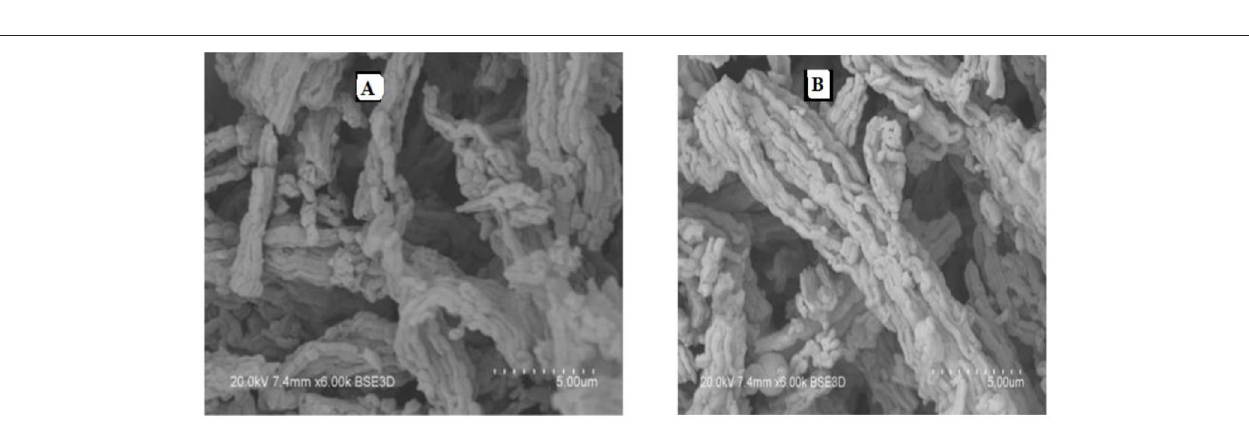
the 13IMPNi18LaN-B spent sample. For the 10IMPNi6LaN- A spent sample, the weight loss was 19.0 wt%, while for the 16IMPNi11LaN-C spent catalyst the weight loss was 22.4 wt%.